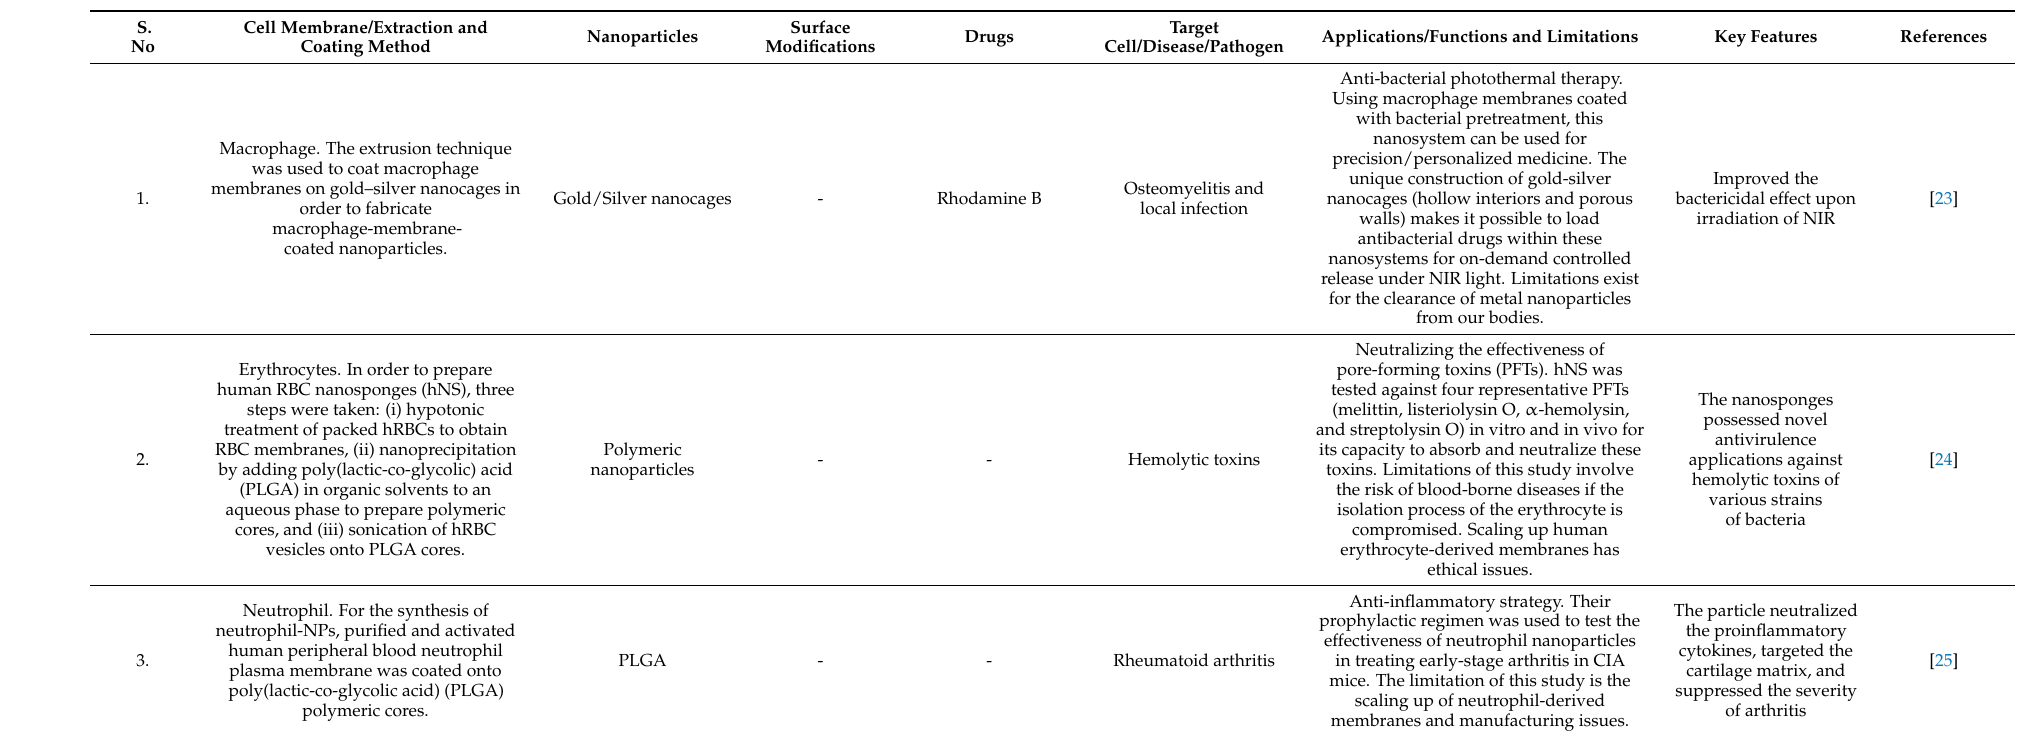
Table 1. Recent Advances in Nanodecoys for Biomedical